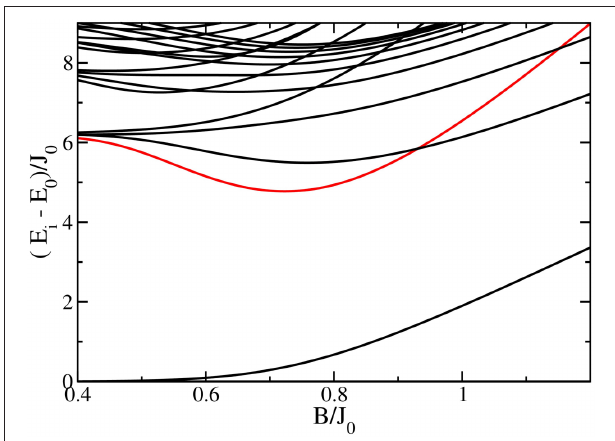
FIGURE 6 | The energy spectra of the ferromagnetic transverse-field Ising model with N = 10 . The red curve shows the first coupled excited state and the minimal gap occurs at B x ≈ 0.72 .